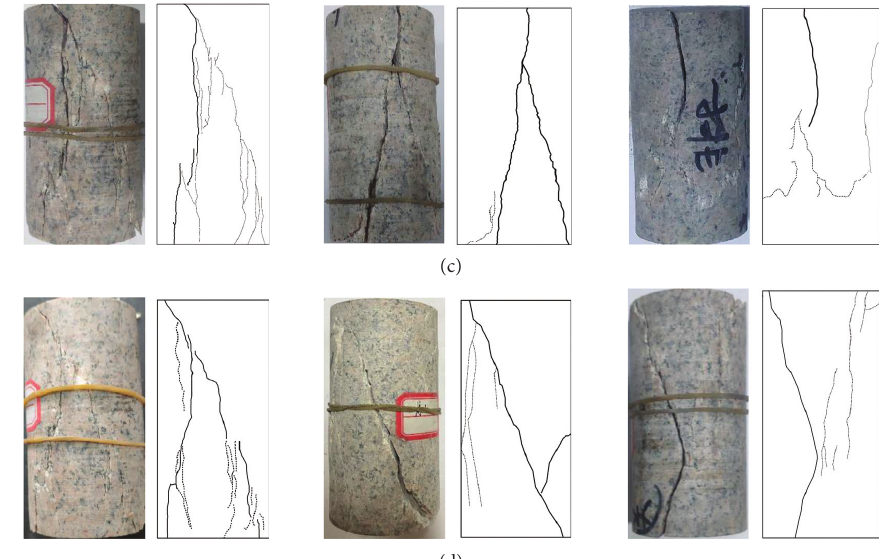
Figure 12: Photos of granite specimens’ facture under unloading confining pressure and triaxial compression. (a) Triaxial compression